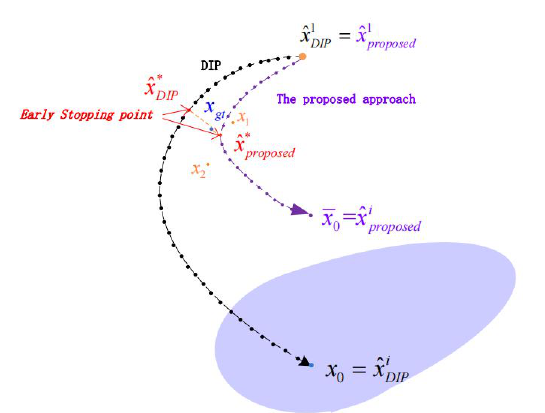
Figure 5. Image space visualization of image denoising using the proposed method and deep image